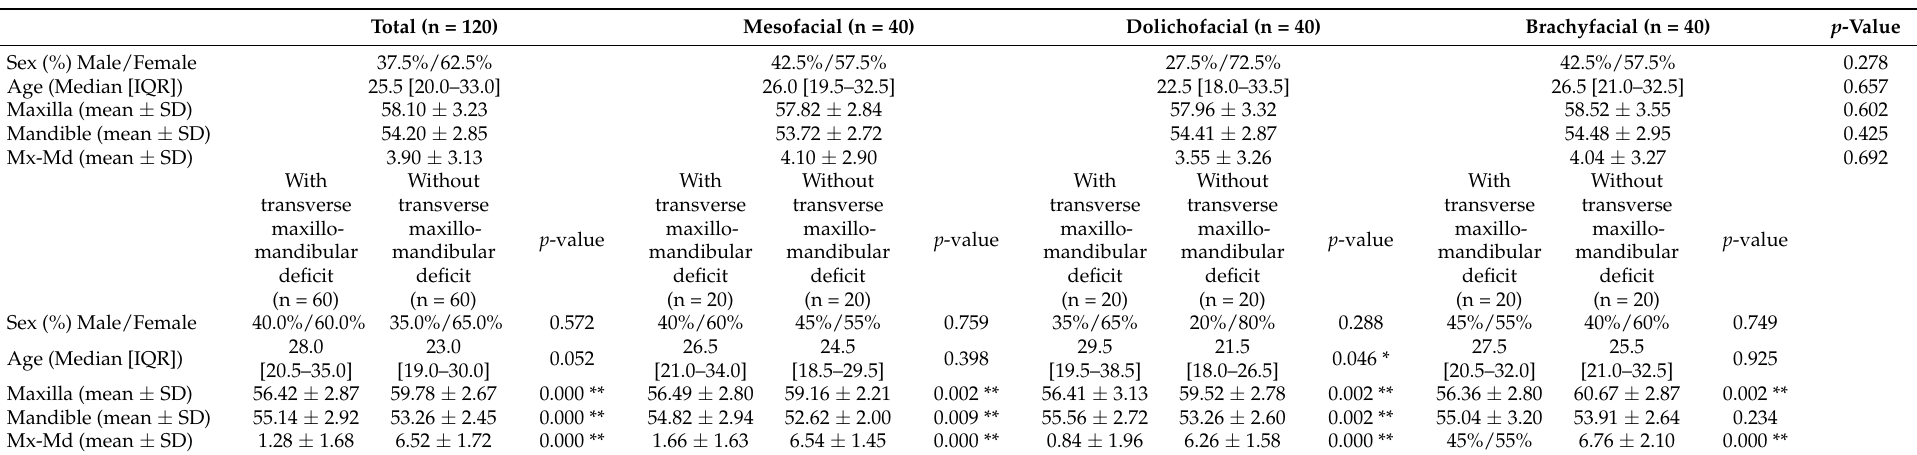
Table 1. Number of subjects and final distribution of the study